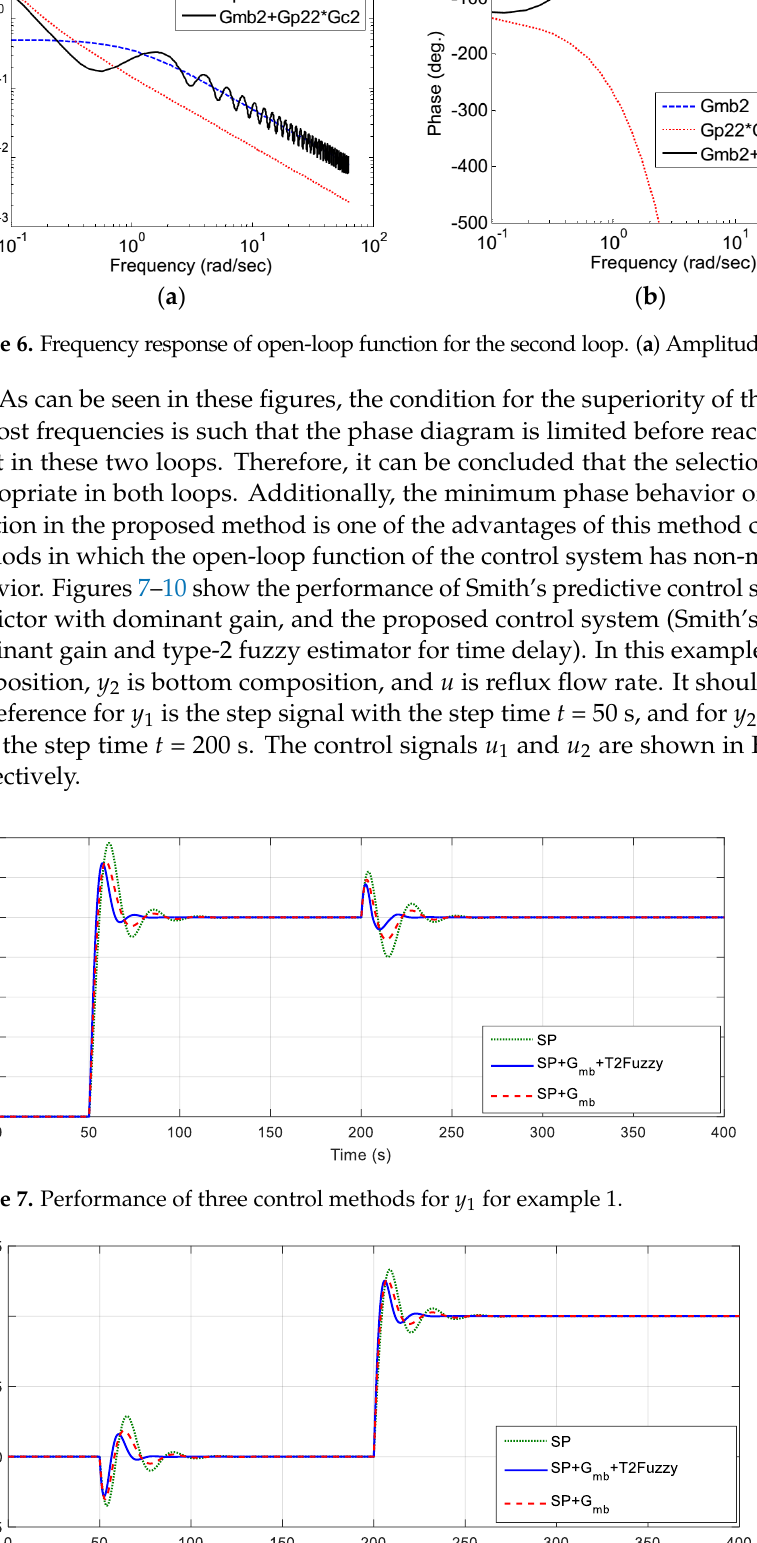
Figure 5. Frequency response of open-loop function for the first loop. (a) Amplitude Ratio (b) Phase